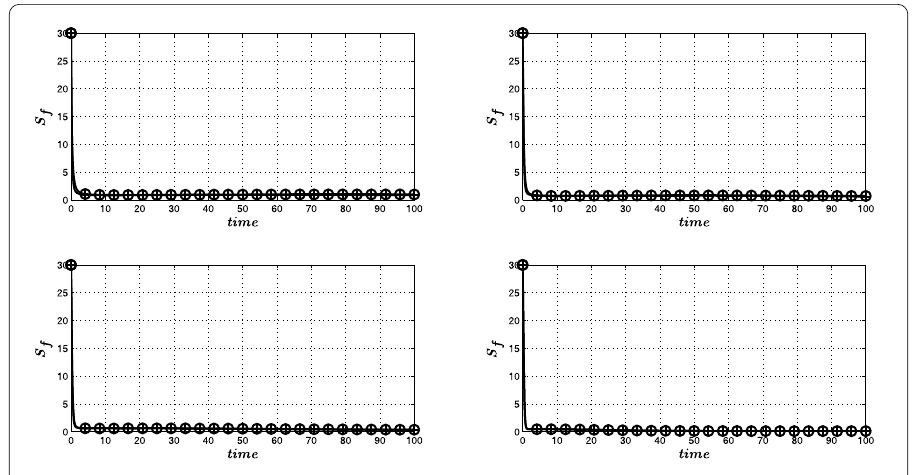
Figure 3 Asymptotic behaviour of S f within the classic Caputo derivative (+) and ABC fractional operator ( (cid:11) ) for different values of α . α = 0.85 (upper-left), α = 0.9 (upper-right), α = 0.95 (lower-left), α = 1 (lower-right)